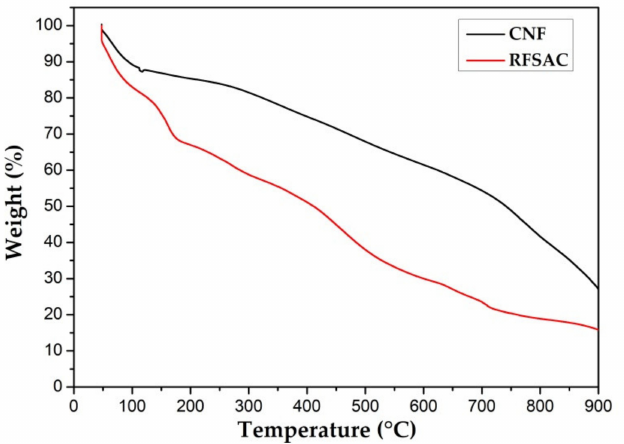
Figure 3. Thermal decomposition analysis result of RFSAC and carbon